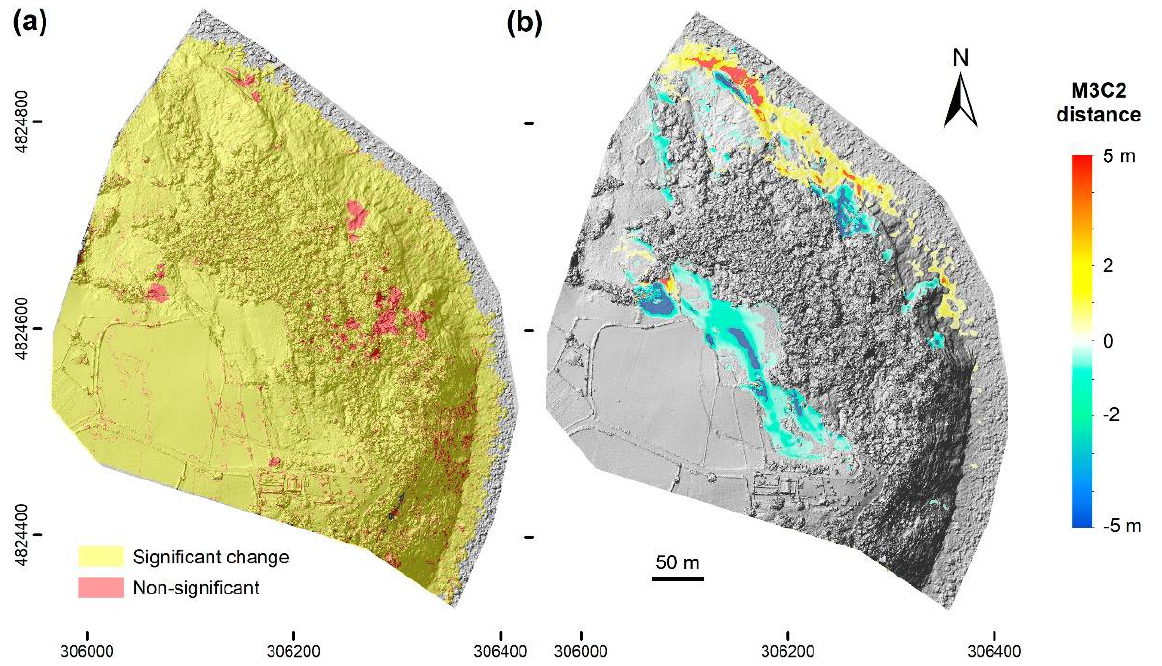
Figure 2. Results of cloud-to-cloud comparison. UTM coordinates referenced to ETRS89 30T. ( a ) Significant change. ( b ) Distance (M3C2).